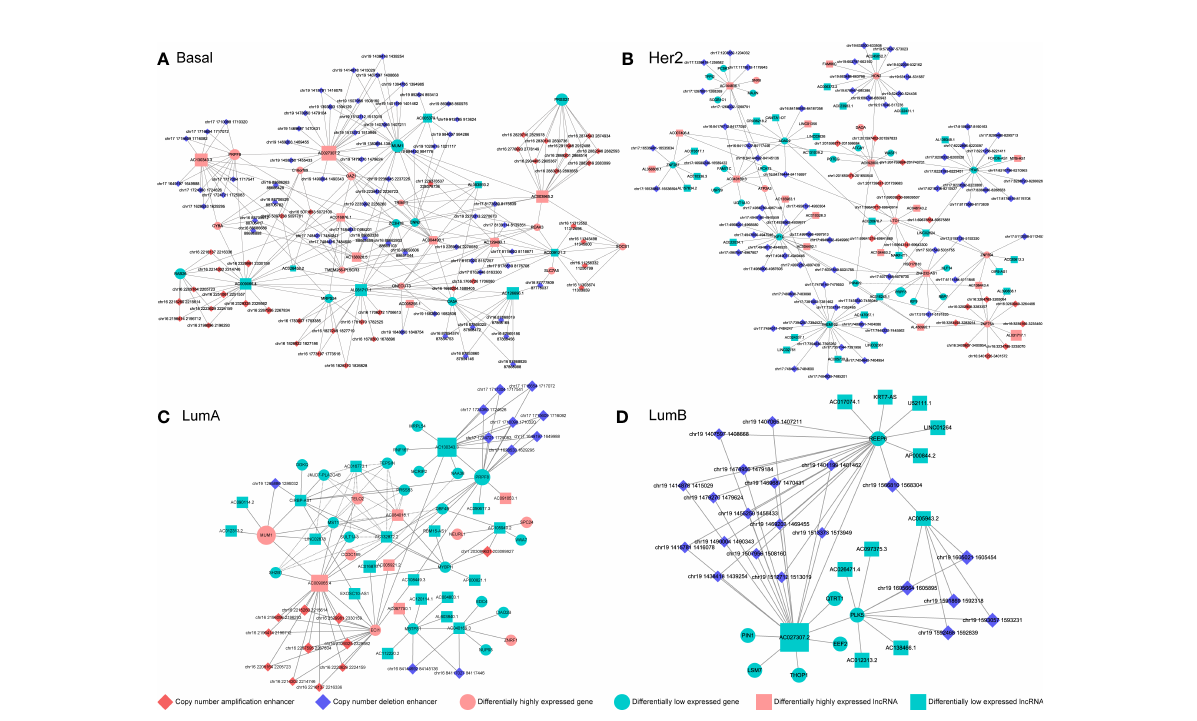
FIGURE 4 The CNV-driven enhancer-lncRNA-mRNA networks in Basal-like subtype (A) , Her2 subtype (B) , LumA subtype (C) and LumB subtype (D) . The diamond represents CNA-driven enhancers (red: ampli fi cation; blue: deletion). The circle and square indicate differentially expressed genes and lncRNAs, respectively. Pink denotes upregulation and green denotes